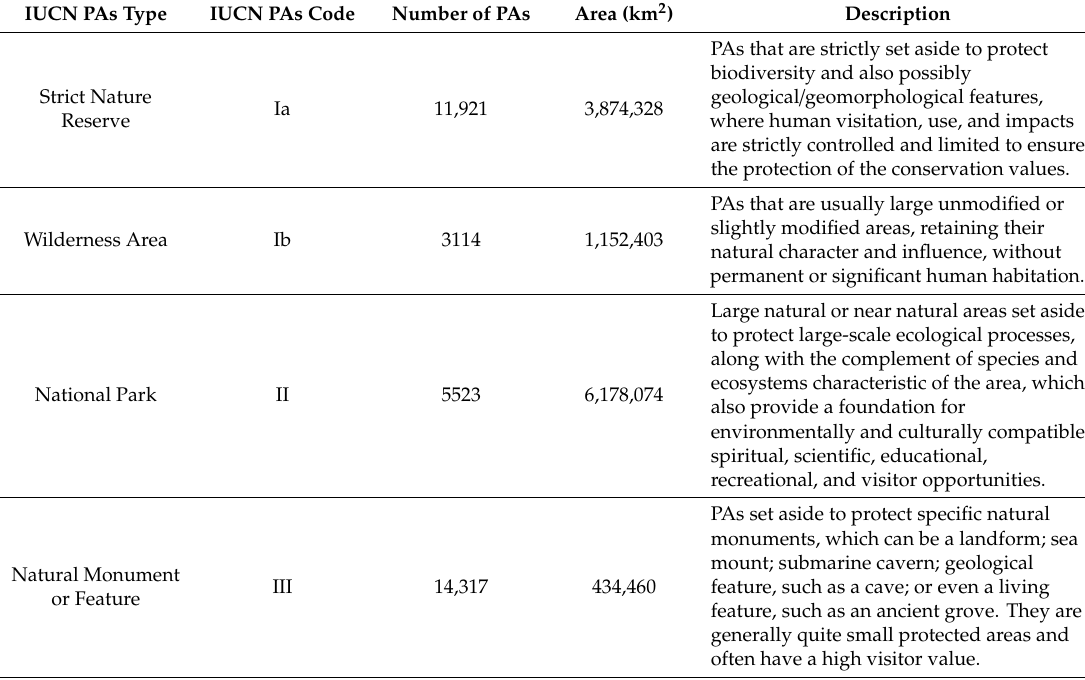
Table 1. Seven types of terrestrial protected areas defined by